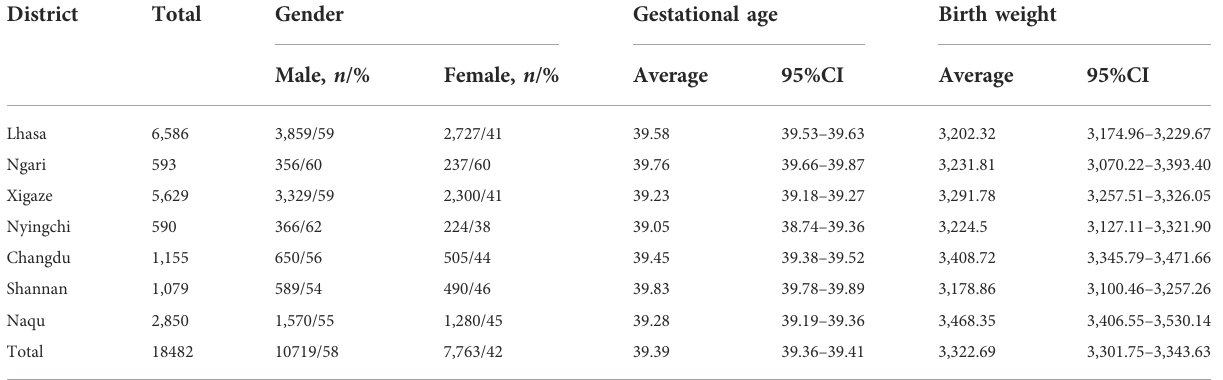
TABLE 1 Distribution of neonates from the Tibet Autonomous